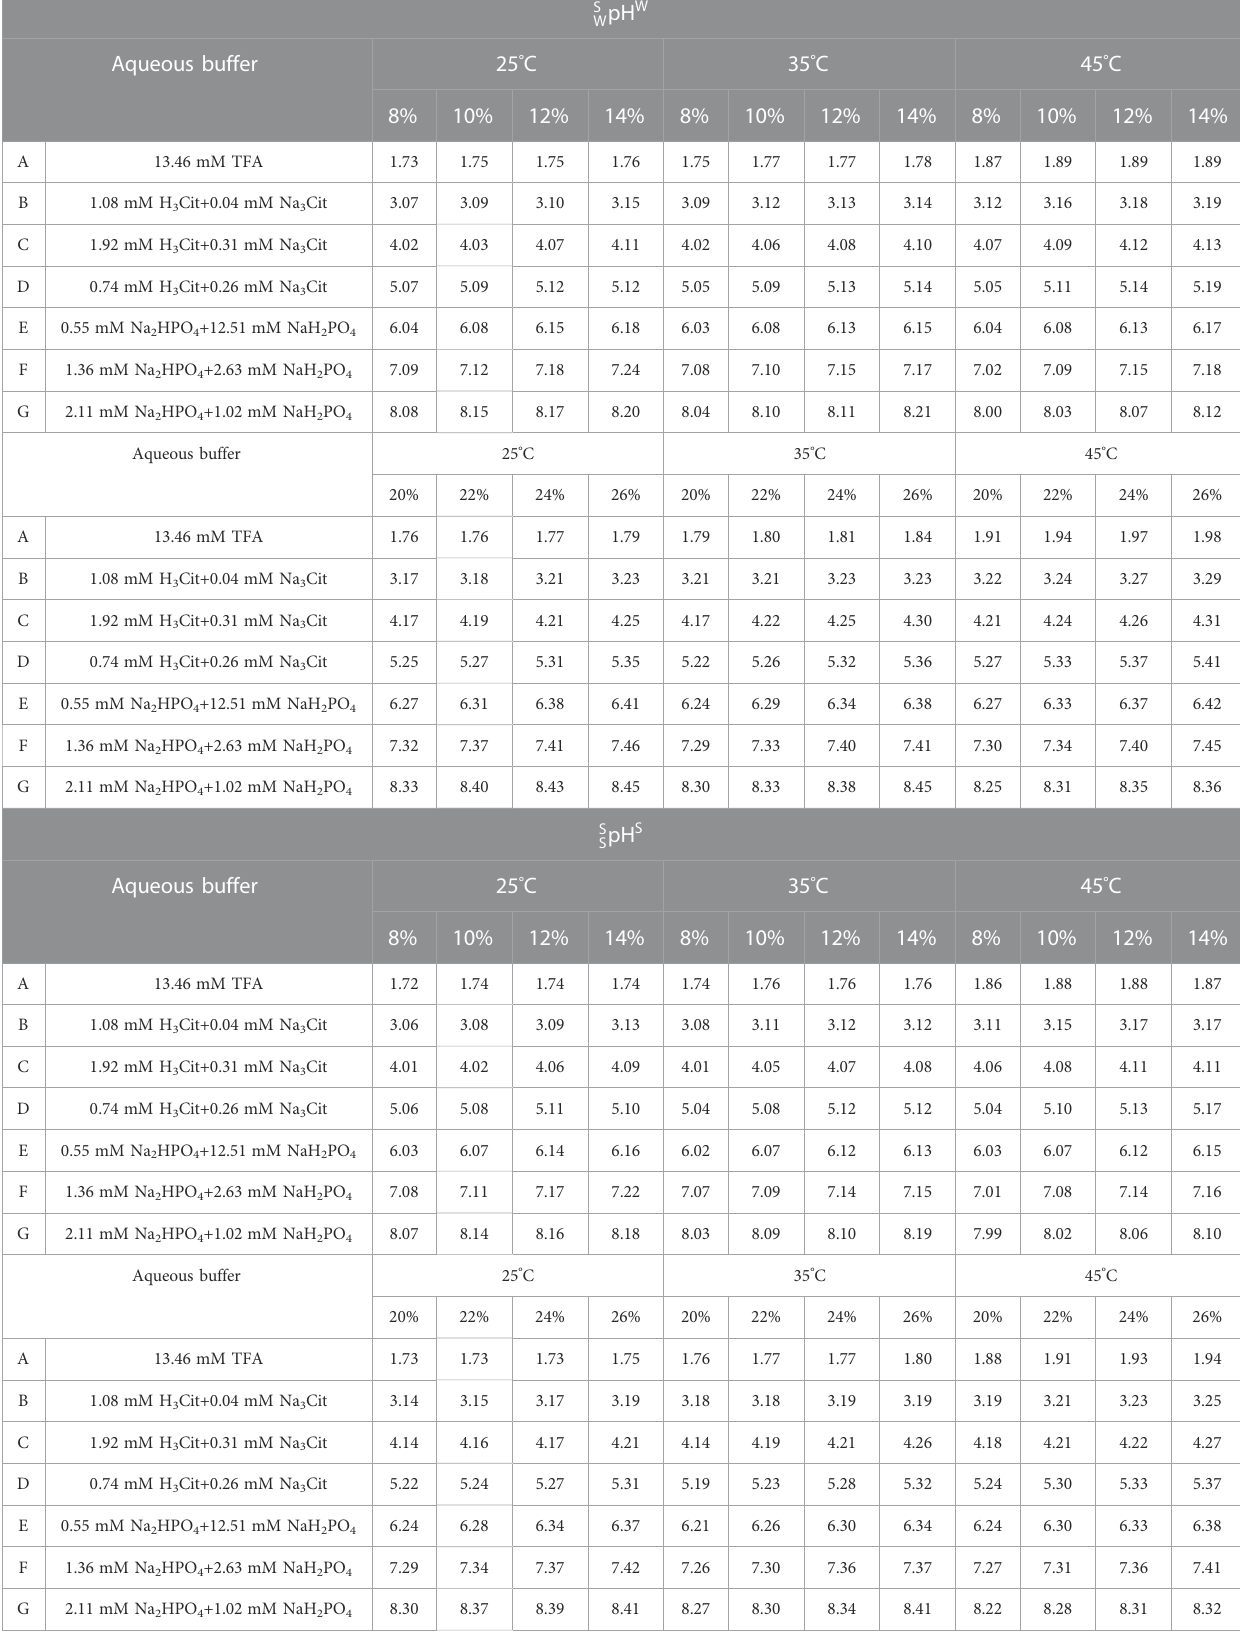
TABLE 1 S W pH W and S S pH S in the mobile phase of high-performance liquid